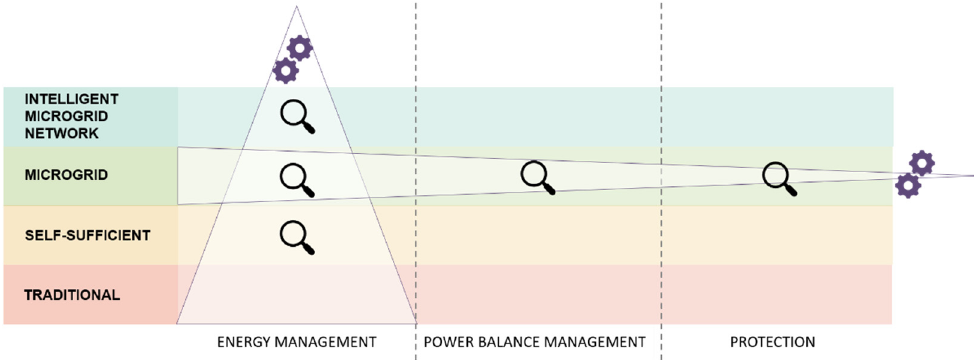
Figure 1. The studied use cases of the developing distribution networks.